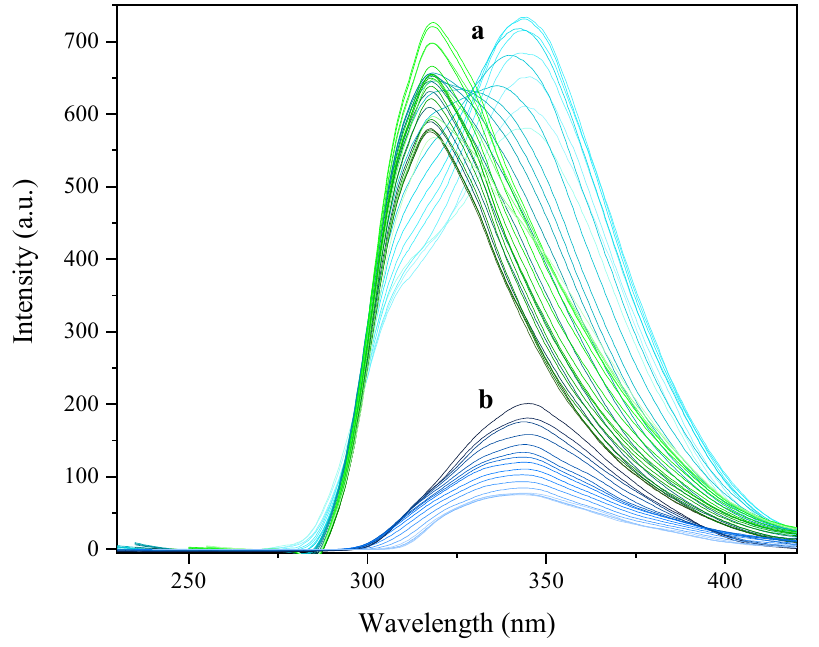
Figure 11. Emission spectra of complex 2 . ( a ) Sample of concentration 1.07 × 10 − 7 M irradiated from 210 to 270 nm. ( b ) Sample of concentration 1.08 × 10 − 8 M irradiated from 210 to 270 nm.